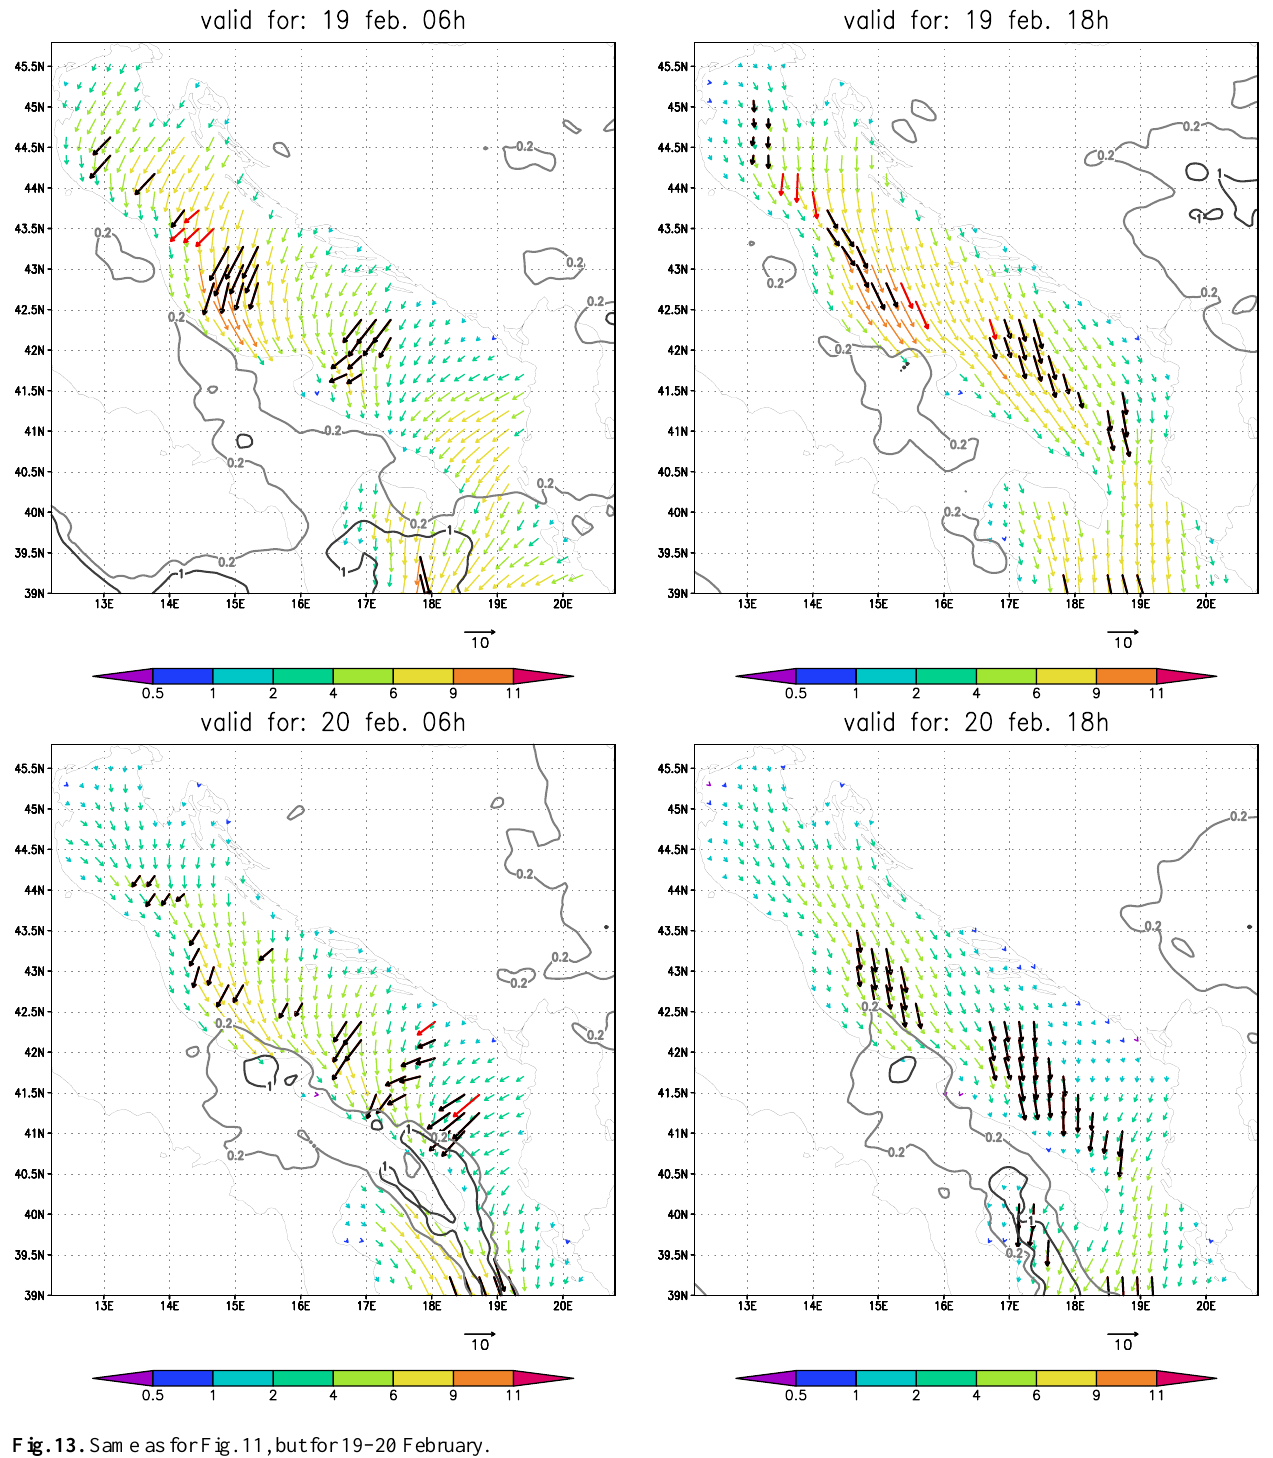
Fig. 13. Same as for Fig. 11, but for 19–20